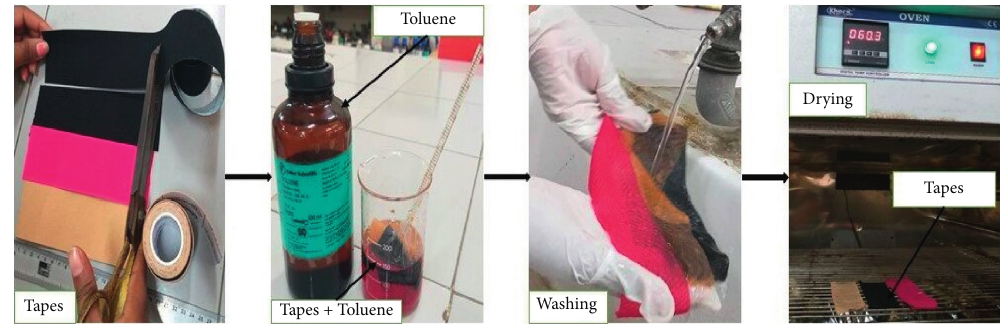
Figure 2: Process of adhesive removal from each